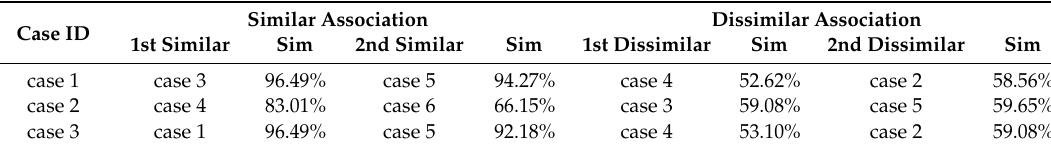
Table 3. Association table for cases from Table